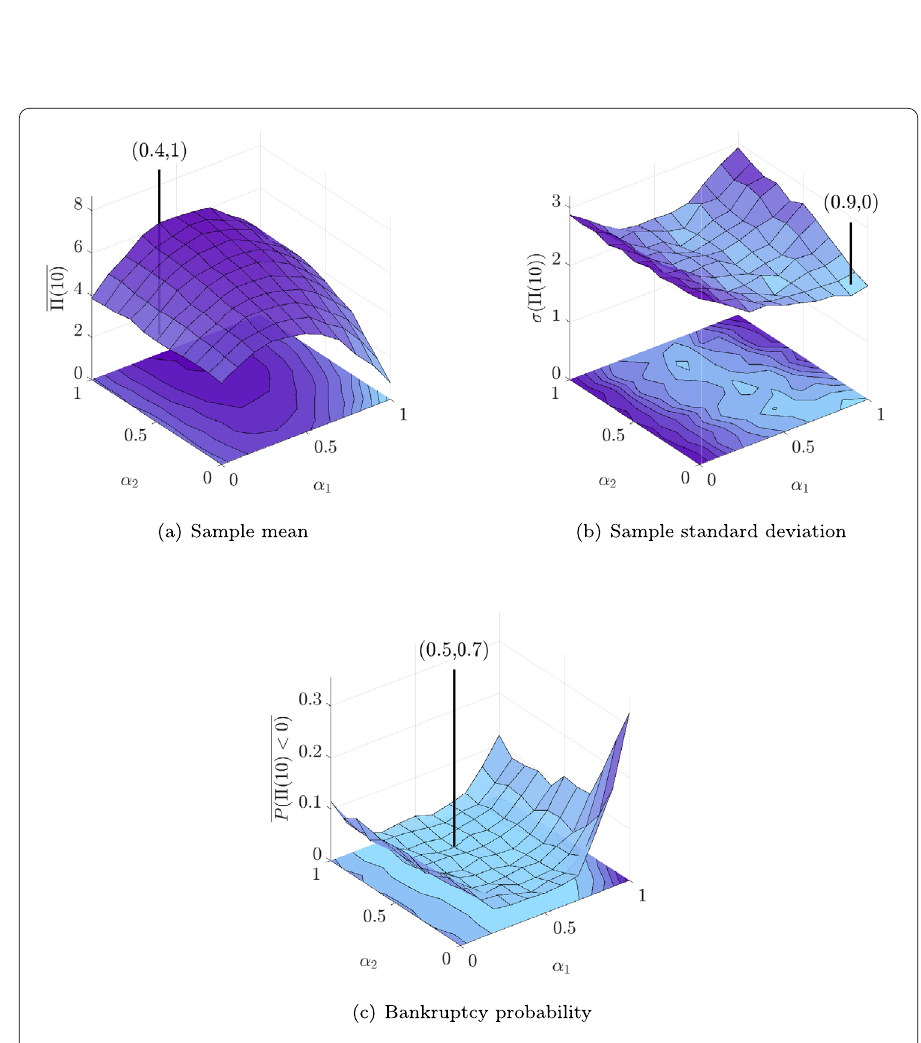
Figure 6 Sample mean, standard deviation and bankruptcy probability of profit for 1000